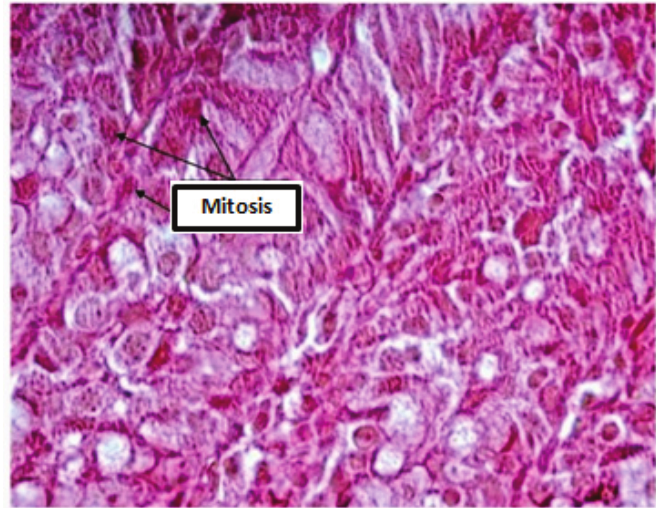
FIGURE 6 - Histological aspect of the animal 1 in the vitamin C operated group, showing a higher number of mitotic figures and tissue preservation (HE 1000x). 3 (HE 1000x). in segment S 2